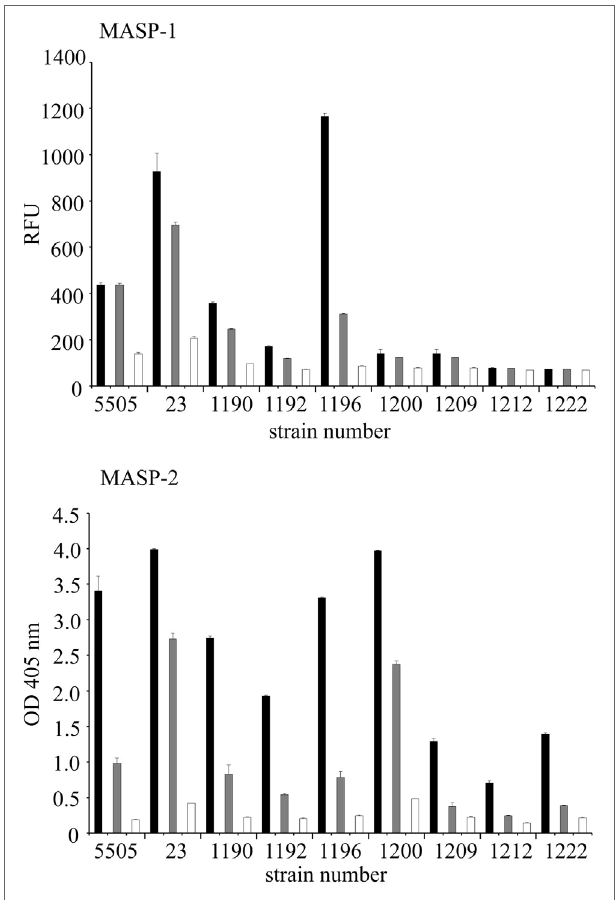
FigUre 7 | Activation of the human lectin pathway of complement by Hafnia alvei LPS. (Top) Human LPS-MASP-1 activity (ability to cleave a VPR-AMC peptide). Black, gray, and white bars represent 5-, 20-, and 40-fold dilutions, respectively. (Bottom) Human LPS–MASP-1/2 complex- dependent C4c deposition. Black, gray, and white bars represent 50-, 200-, and 800-fold dilution, respectively. Each dilution series is described by the strain number on the X -axis. Pattern recognition molecule states for MBL or other complement-activating collectin/ficolin present in serum. Data represent the mean values of four replicates. LPS were used as solid phase. Abbreviations: RFU, relative fluorescence units; OD, optical density measured at λ = 405 nm; LPS, lipopolysaccharide; MBL, mannose-binding lectin; MASP, MBL-associated serine proteases.